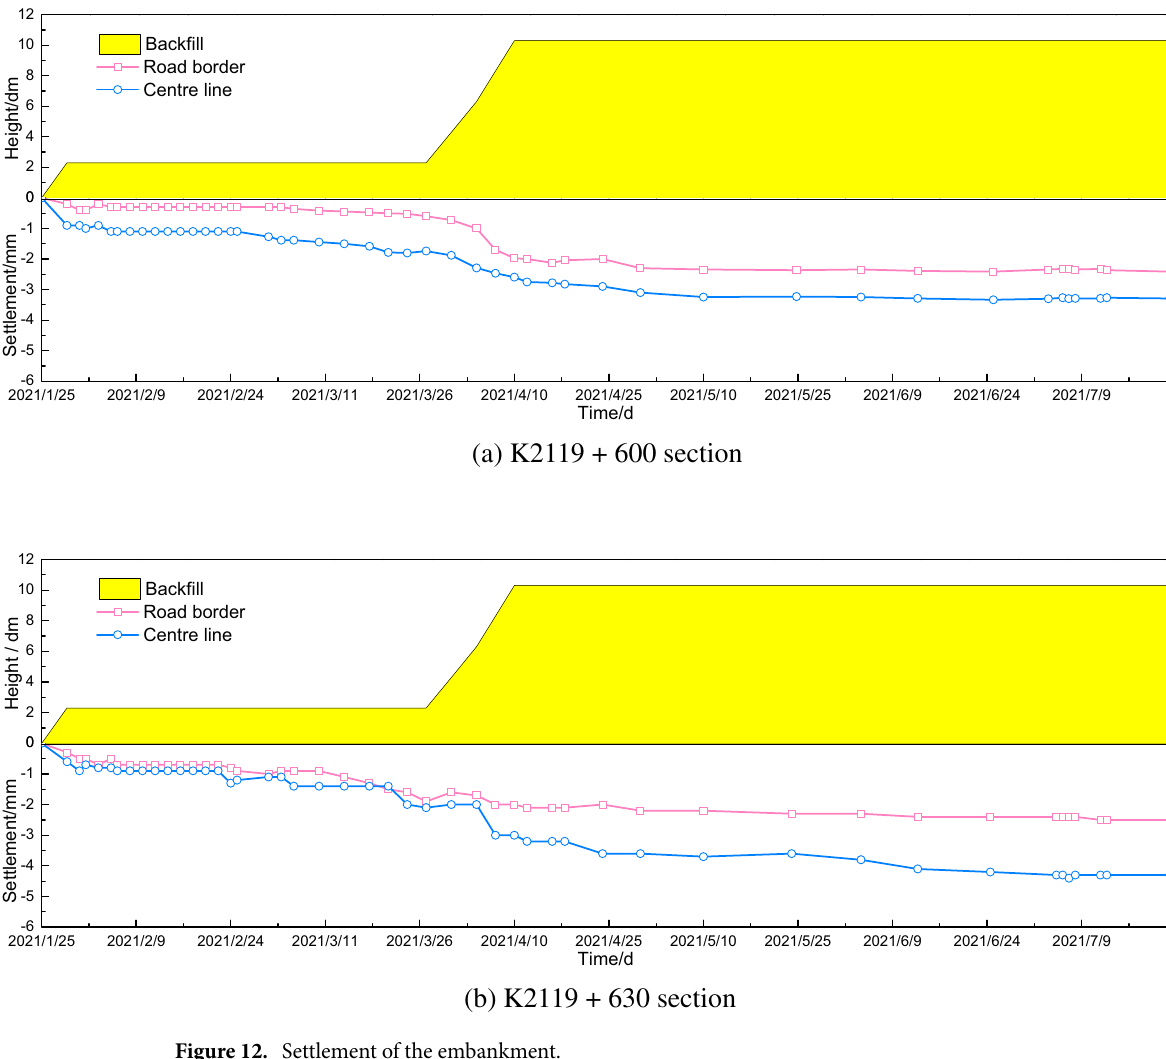
Figure 12. Settlement of the